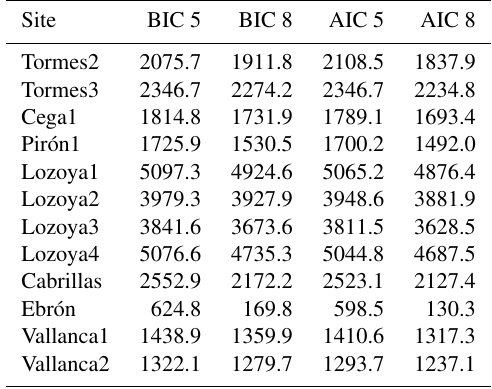
Table 5. Bayesian (BIC) and Akaike (AIC) information criteria val- ues for the stream-temperature models with five and eight parame-